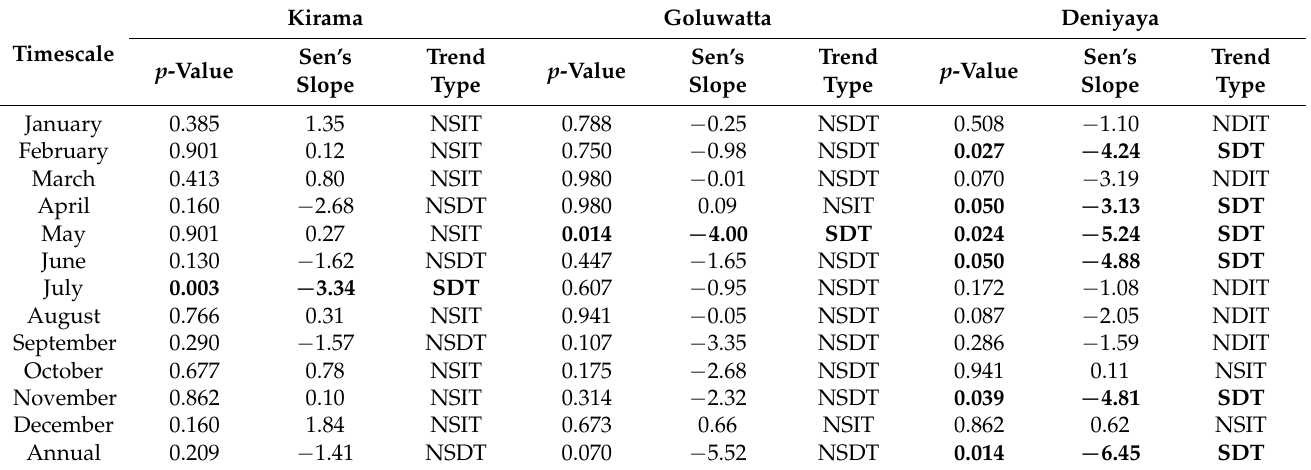
Table 7. Trend analysis results for the extreme rainfall indices (Rx5).